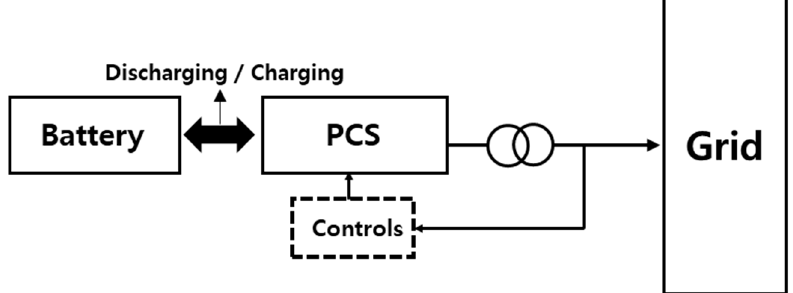
Figure 3. Configurations of the battery energy storage system (BESS).